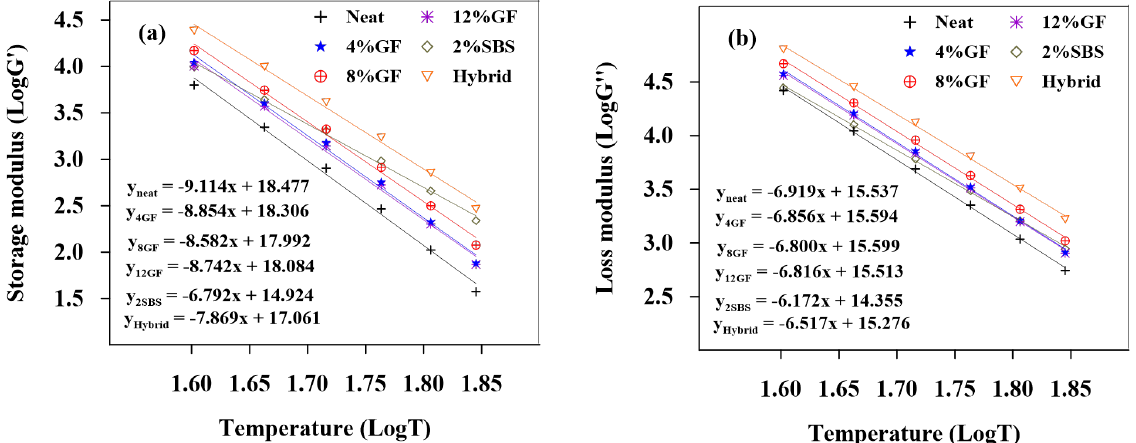
Figure 4. Temperature sensitivity of the ( a ) storage and ( b ) loss modulus of unaged binders.